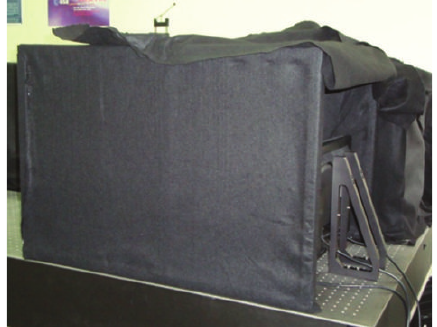
Figure 4: Black box for electro-optical